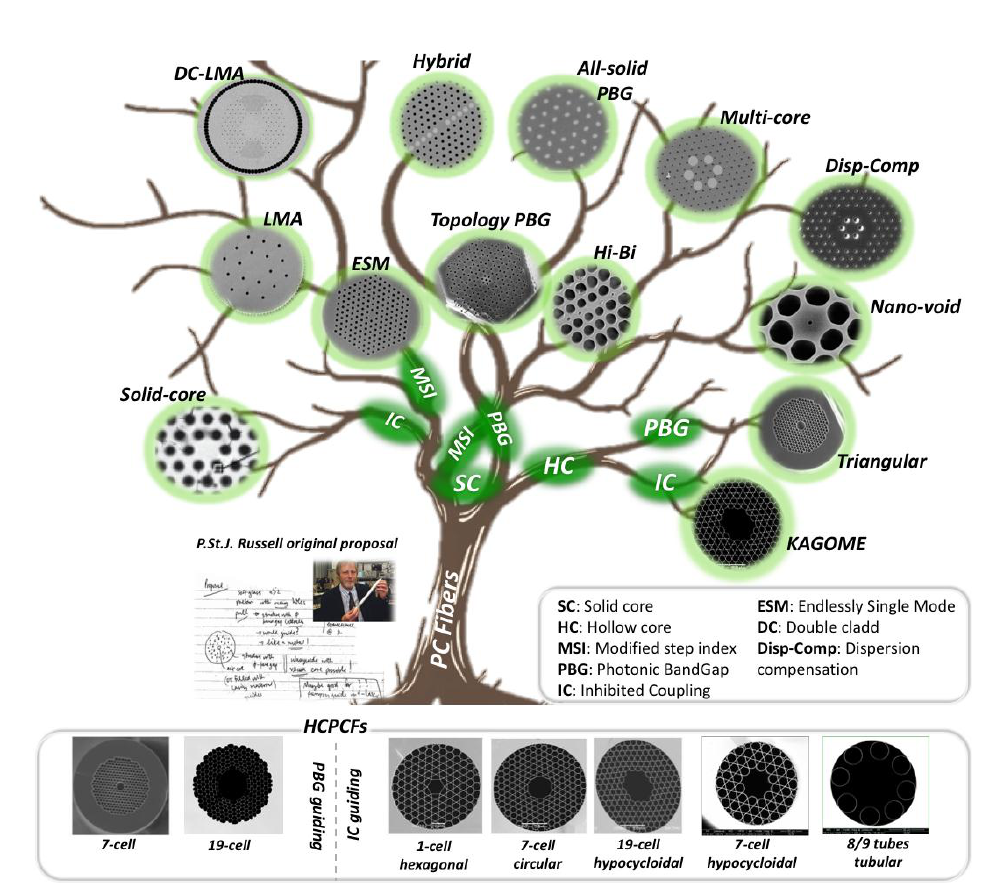
Figure 2. Photonic crystal fibers family tree diagram (top). Micrographs of HCPCF-based on PBG guidance and IC